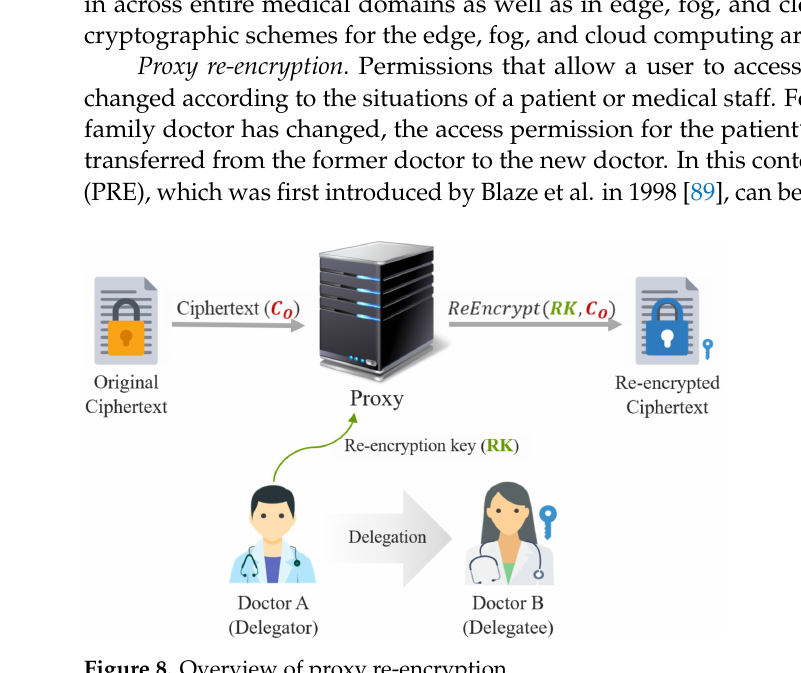
Figure 8. Overview of proxy